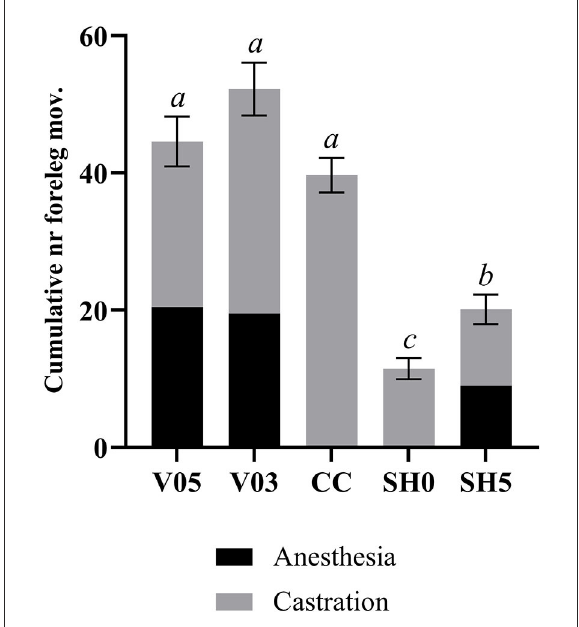
FIGURE2 Combined number of foreleg movements recorded during injection of local anesthetic and castration. Different letters indicate significant differences between treatments, P adj ≤ 0.05. Error bars indicate standard errors of the cumulative averages. V05, intra-testicular injection of 0.5mL of anesthetic per testis ( n = 55); V03, intra-testicular injection of 0.3mL of anesthetic per testis ( n = 56); CC (control-castrated), castration without anesthesia ( n = 58); SH0, sham handling with one stay in the bench ( n = 58); SH5, sham handling with two stays in the bench ( n =